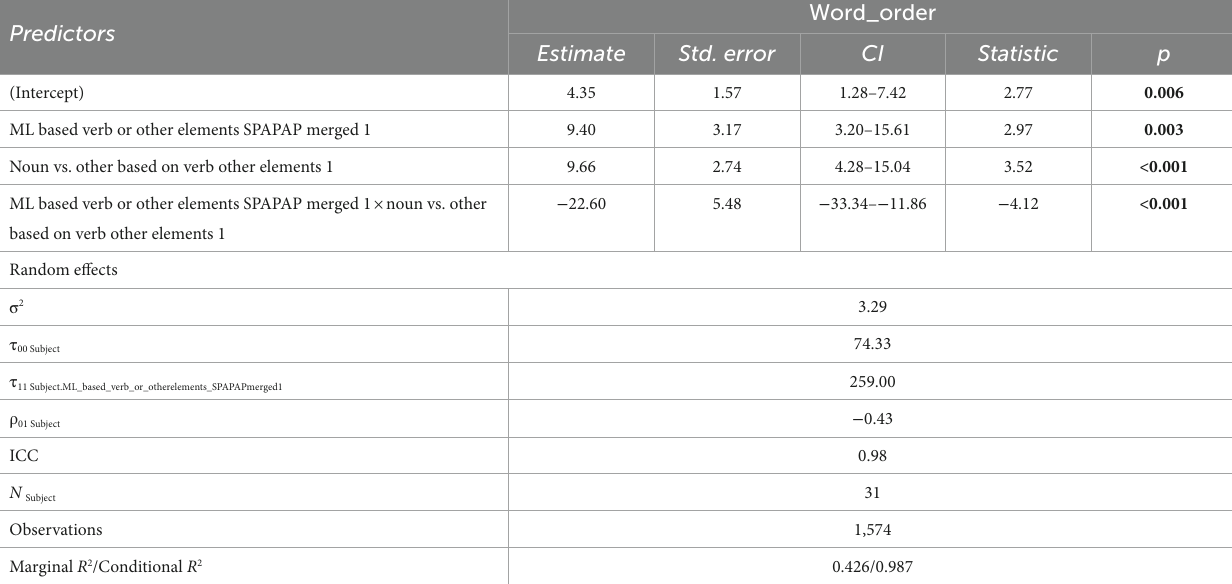
TABLE 6 Output for the final model including linguistic variables.